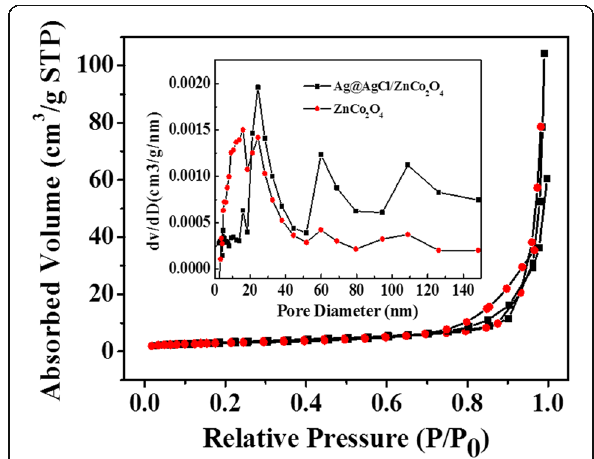
Fig. 5 Nitrogen adsorption-desorption isotherms and pore size distribution of ZnCo 2 O 4 and 0.2Ag@AgCl/ZnCo 2 O 4